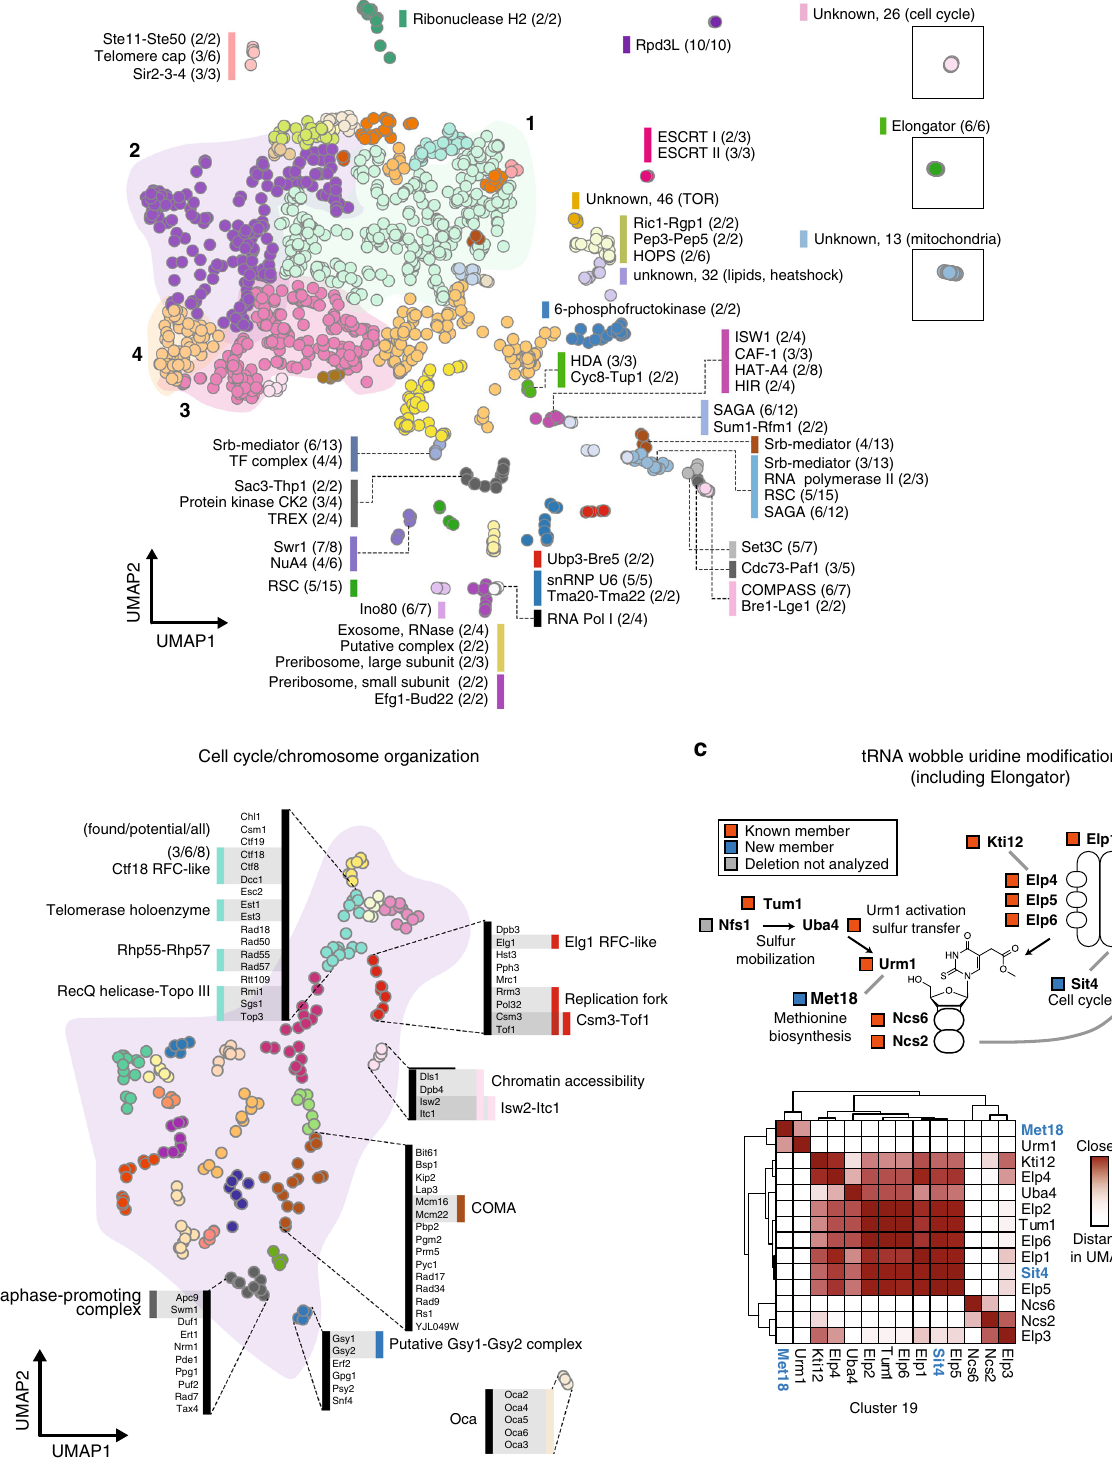
Performing clustering in UMAP space ought to produce clusters containing more true interactions than distance in other spaces. To test whether similar results were obtained without UMAP dimensionality reduction, we clustered the data in PCA space. Clustering in PCA space identi fi ed 8/50 clusters with perfect overlap to UMAP clusters, and 34/50 that overlap by at least 50% (Supplementary Fig.